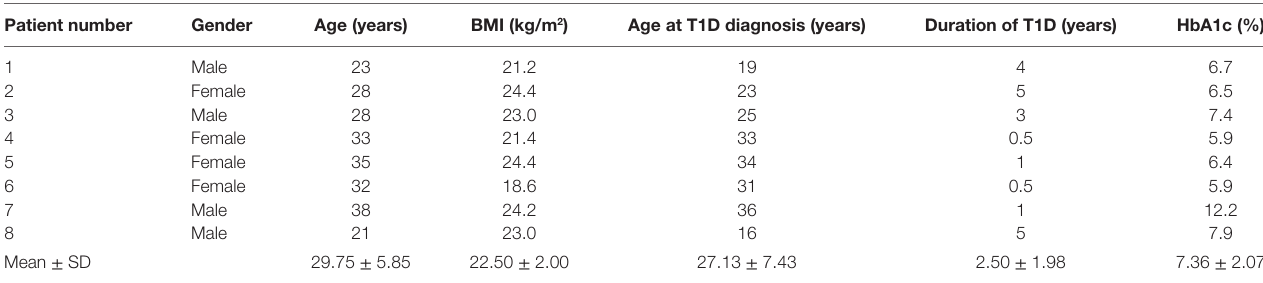
Table 2 | Data from the patients with T1D included in the RNA-seq